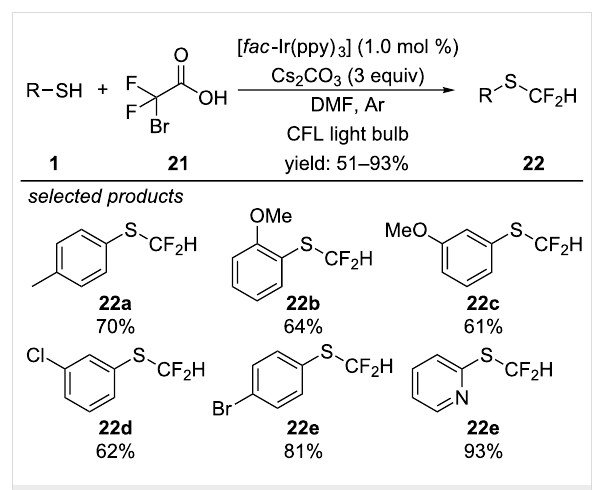
combined photoredox catalysis with transition metal